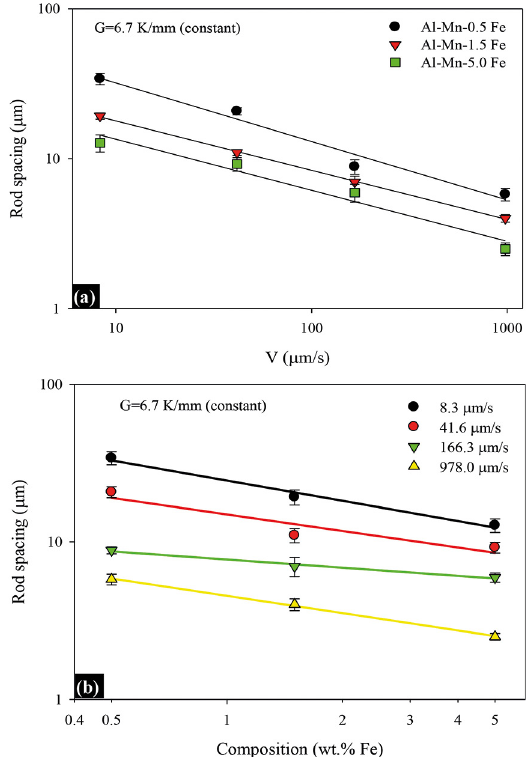
Fig. 7 (a)Variation of λ versus V for different Fe contents (b)Variation of λ versus